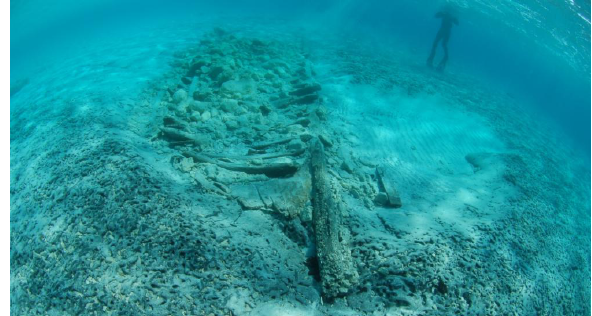
Figure 12. Wreck from the Bacino Grande at a 2 m depth at Porto Cesareo (LE-IT) between Torre Lapillo and Torre